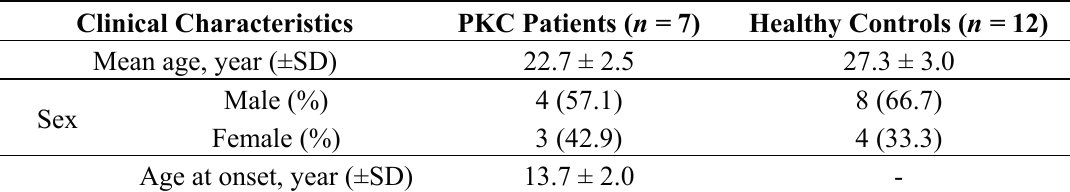
Table 1. Characteristics of the subjects.